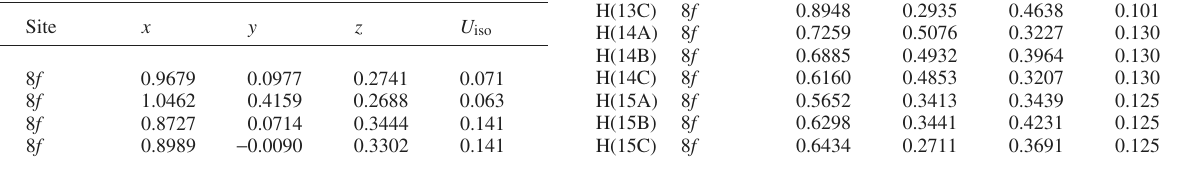
Table 2. Atomic coordinates and displacement parameters (in Å 2 )